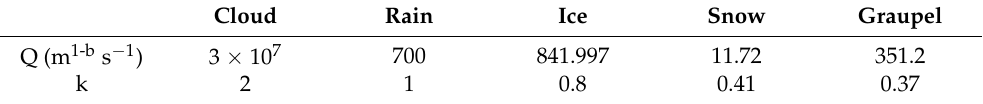
Table 2. The coefficients in the equation for the terminal velocity of different hydrometeors.